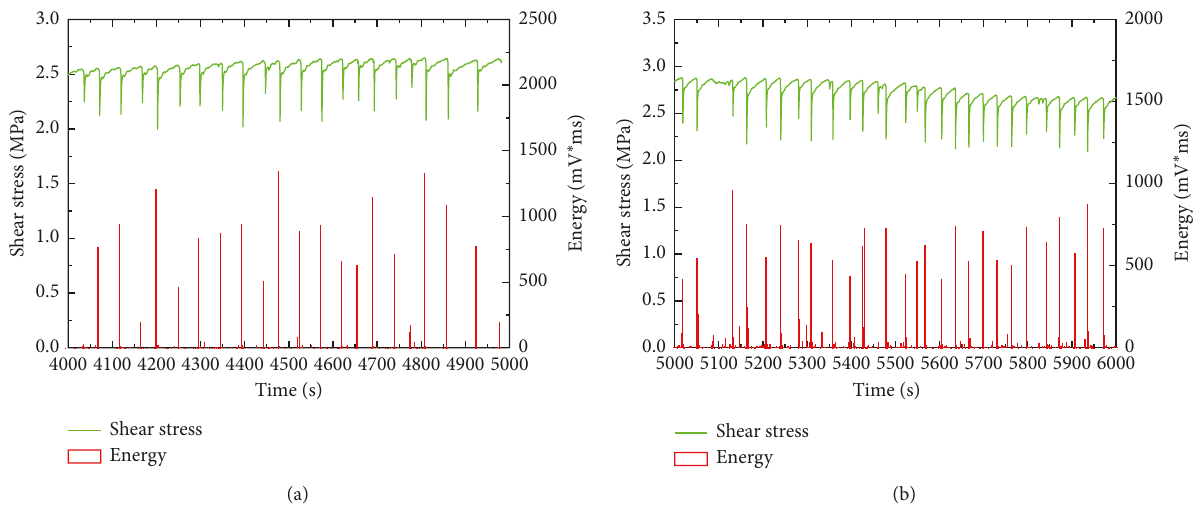
Figure 6: Relationship between shear stress and AE energy of (a) Sample 2 and (b) Sample